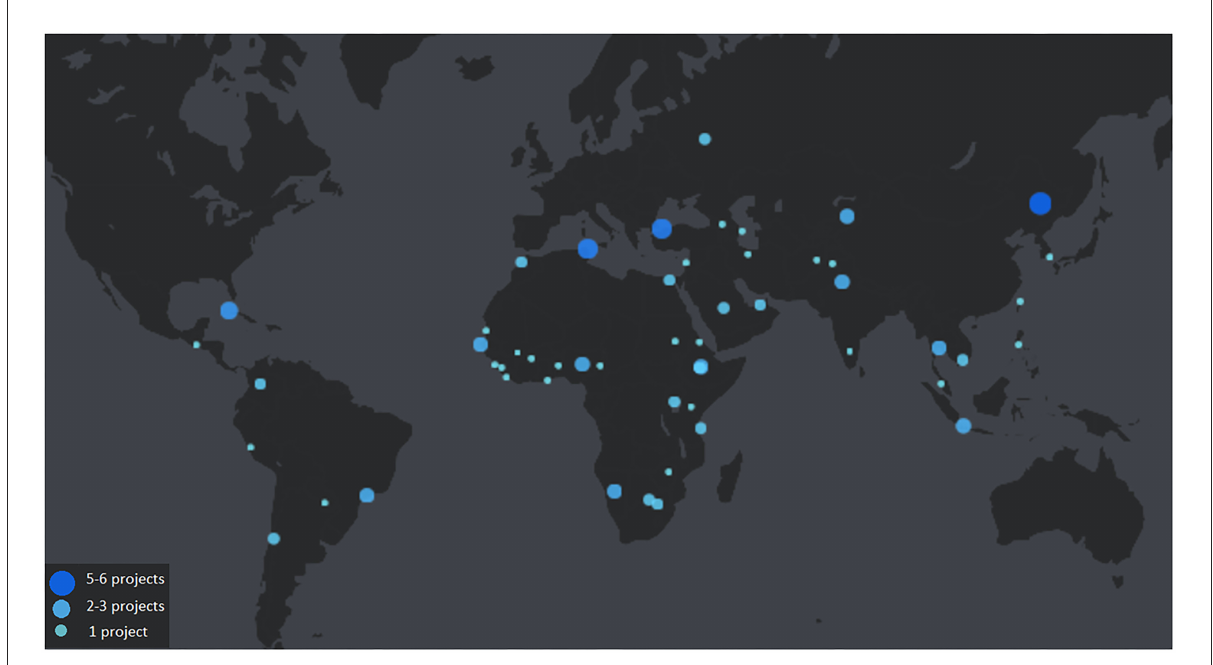
FIGURE1 Global distribution of WOAH Laboratory Twinning projects implemented in the period 2006–2022. Larger dots indicate a higher number of projects implemented in one country.